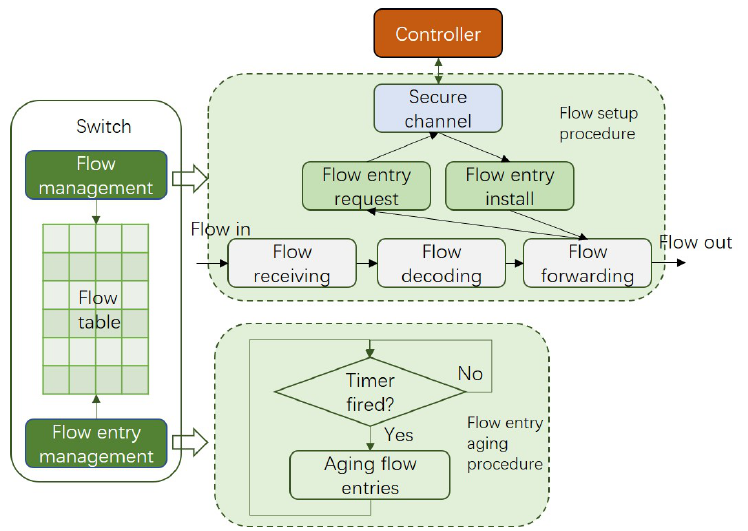
Figure 2. Major functions of SDN